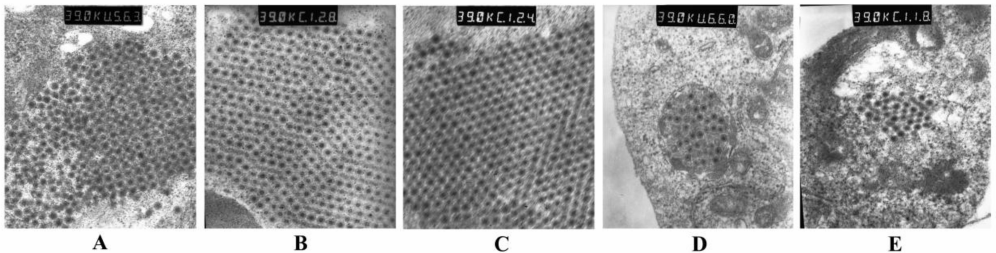
Figure 2. Ultra-thin sections from infected CIK cells: ( A ) GCRV GZ1208, ( B ) GCRV 873, ( C ) GSRV, ( D ) GCRV HZ08, ( E ) HDGRV × 39,000.